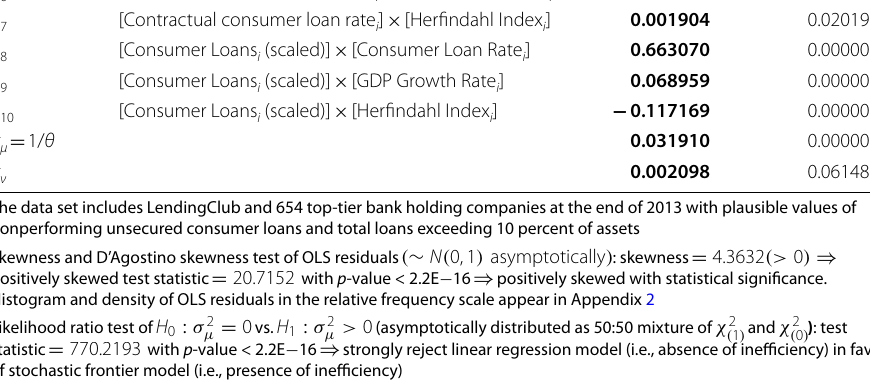
Table 4 2013 unsecured consumer loans. Including the volume of unsecured consumer lending. Summary statistics of nonperformance derived from stochastic frontier estimation